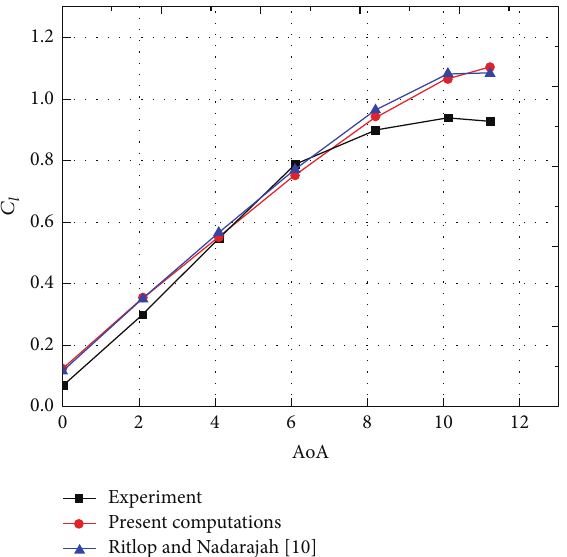
Figure 4: Variation of lift coefficient with angle of